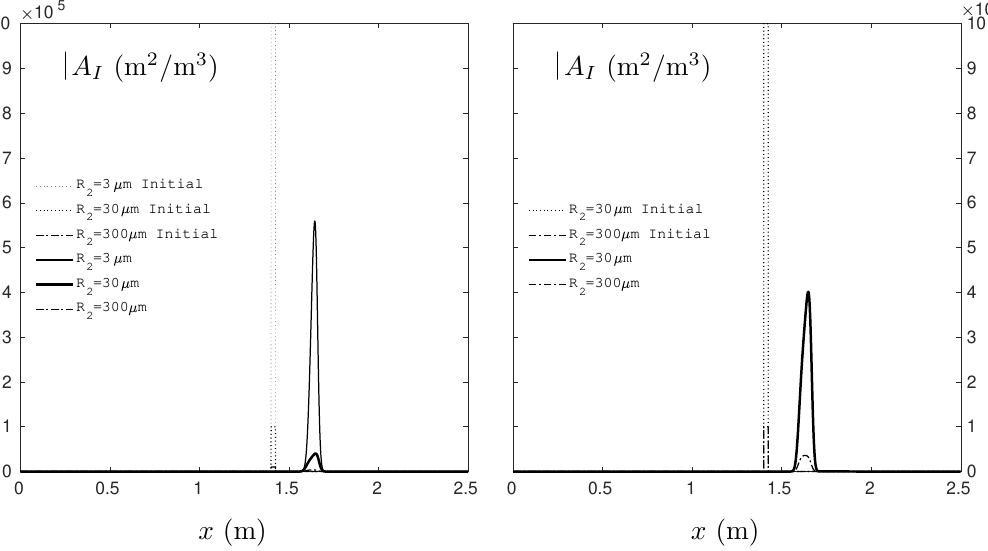
Figure 8: Simplified two-phase explosion test depicted in Fig. 5. Comparison of the monosdisperse results with various initial Figure 8. Simplified two-phase explosion test depicted in Figure 5. Comparison of the monodisperse radii: R t =0 = 3 µ m, R t =0 = 30 µ m and R t =0 = 300 µ m. All results are given at time t = 1 . 2 ms. The specific interfacial area 2 2 2 = 3 µ m, R t = 0 = 30 µ m and R t = 0 = 300 µ m. All results are results with various initial radii: R t = 0 A I is presented for all radii on the left. On the right, a close-up view is shown. 2 2 2 given at time t = 1.2 ms. The specific interfacial area A I is presented for all radii on the left. On Results provided by Fig. 6 indicate that the larger the liquid particles are, the faster the incident shock wave goes.